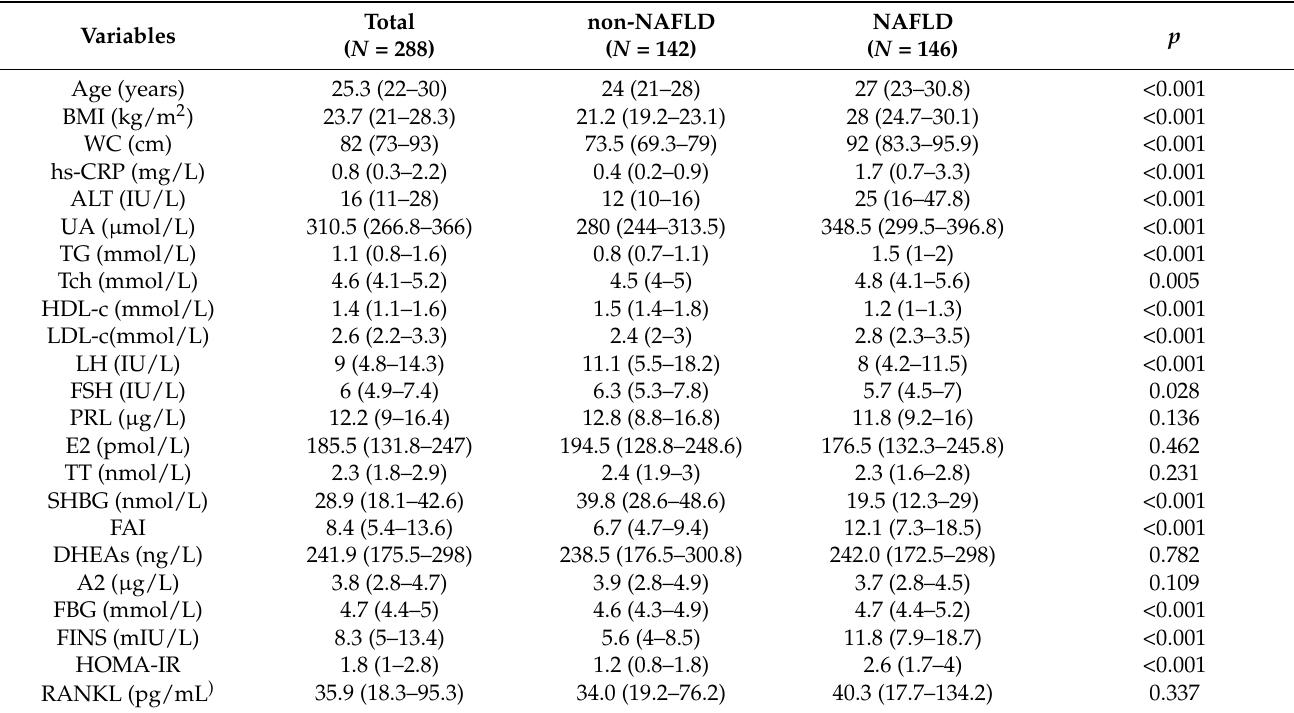
Table 1. Biochemical and clinical features of polycystic ovary syndrome patients stratified by the presence of non-alcoholic fatty liver disease (NAFLD).